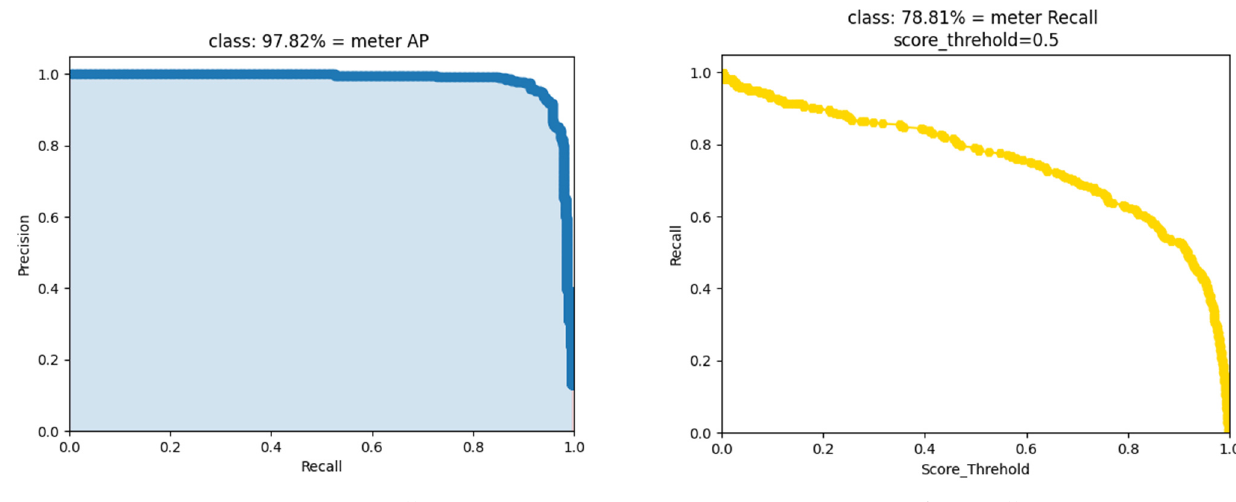
Figure 10. Curves of precision–recall and recall.